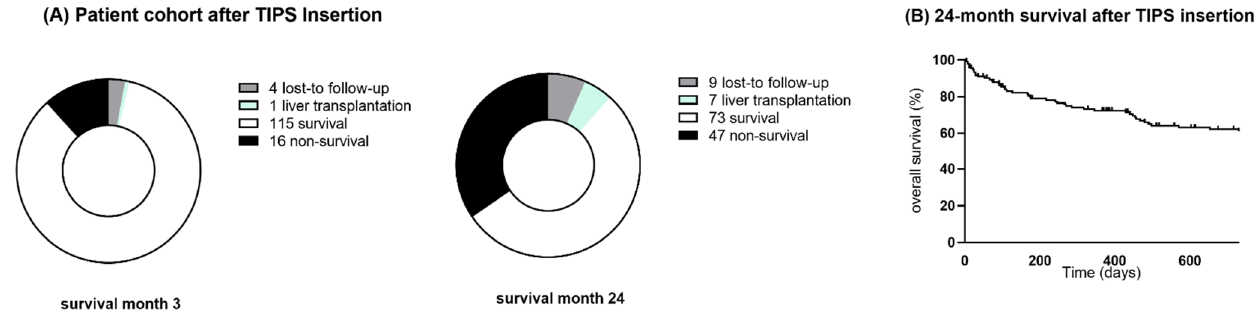
Figure 1. ( A ). Patient cohort 3 months and 24 months after TIPS insertion. ( B ). LTF survival of patients 2 years after TIPS insertion.